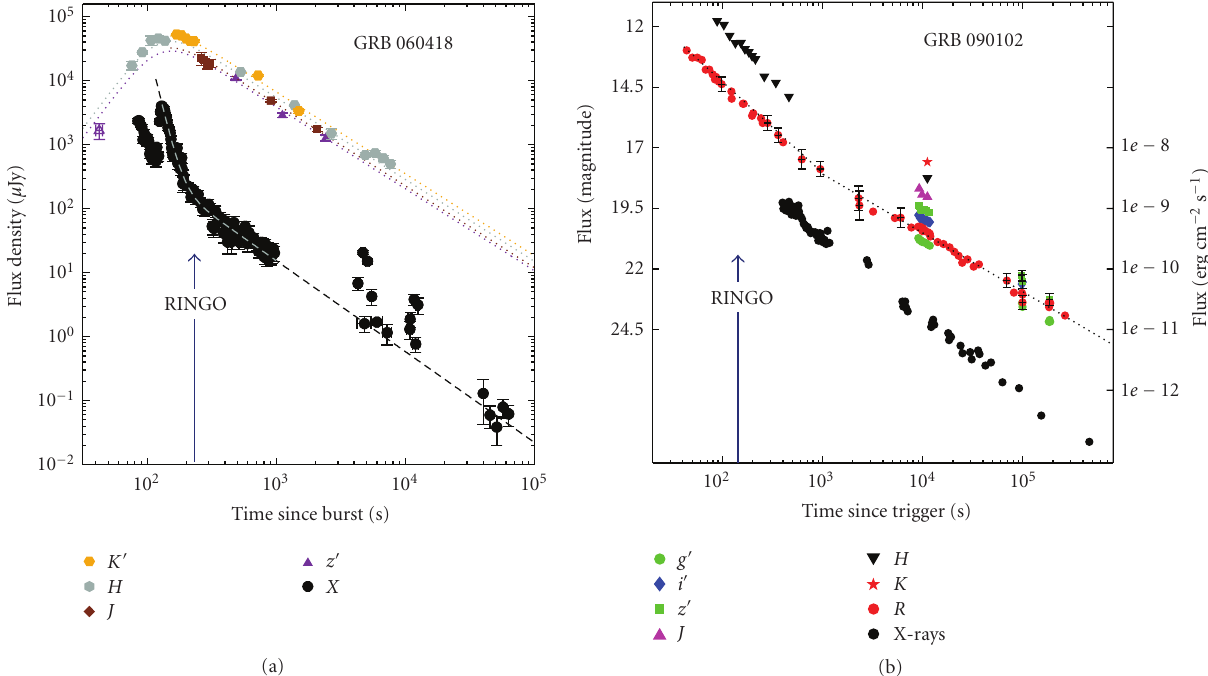
Figure 11: Light curves of GRB 060418 and GRB 090102 with time of RINGO observation marked at 203 seconds and 160 seconds (adapted from [89] and [90]),